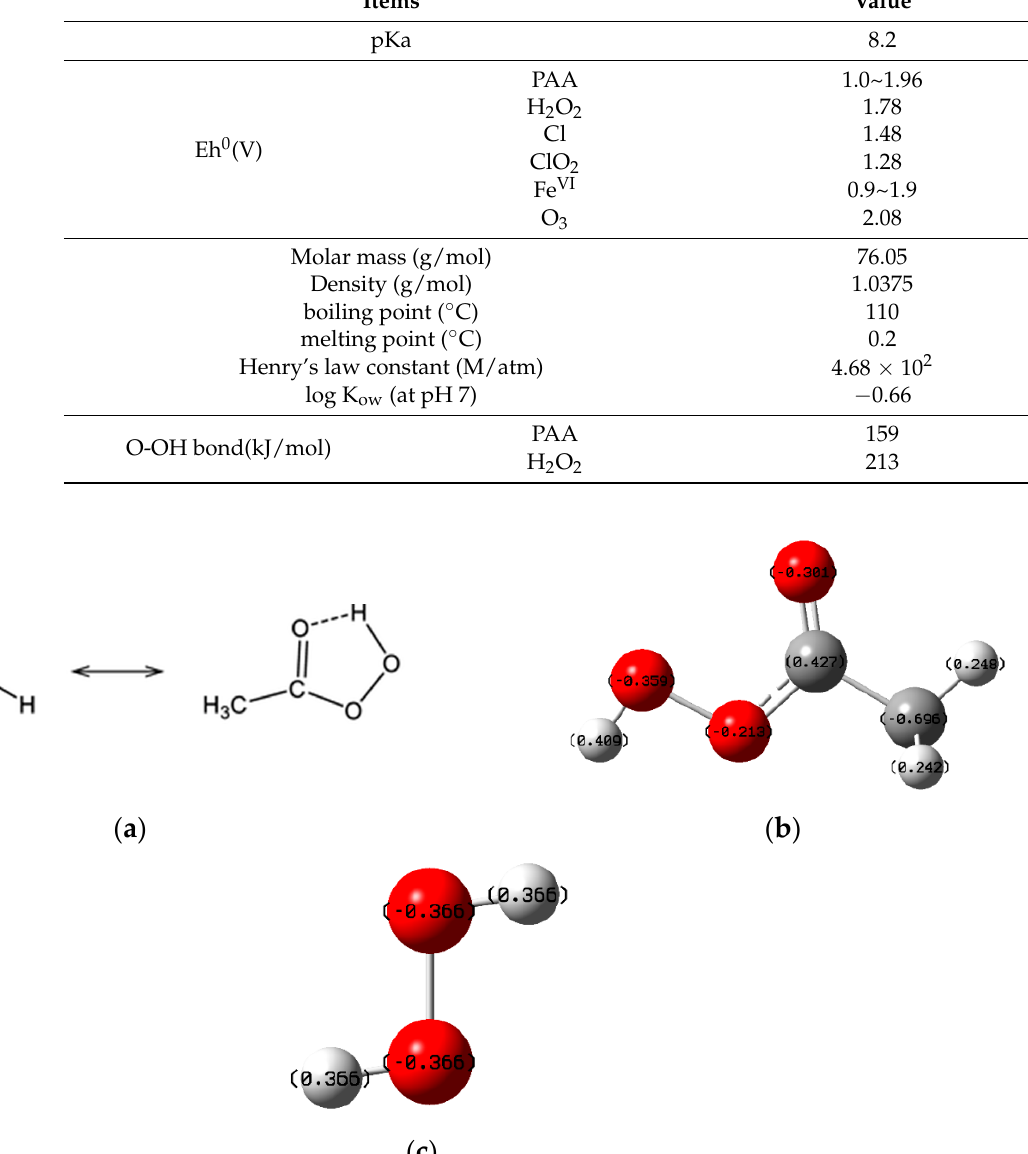
Table 1. Properties of PAA and other oxides.